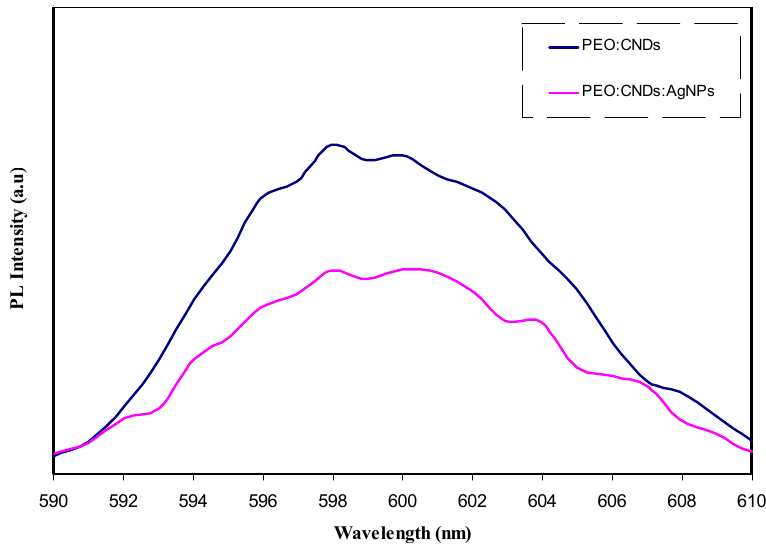
Figure 7. The photoluminescence (PL) spectra at excitation wavelength of 300 nm for the PEO:CNDs (PEPN1) and PEO:CNDs:Ag (PEPN2) nanocomposites.